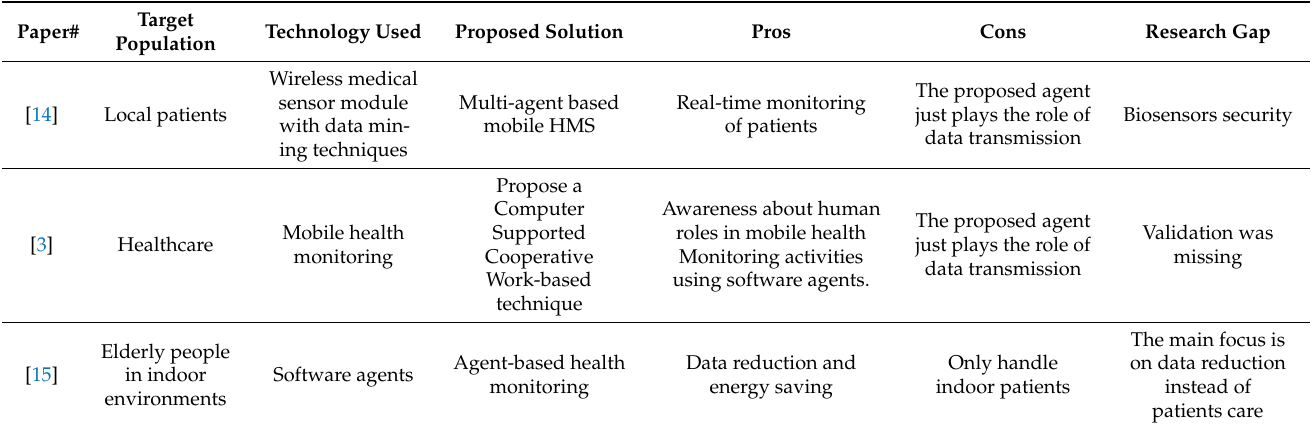
Table 2. Comparison of existing literature on agent-based